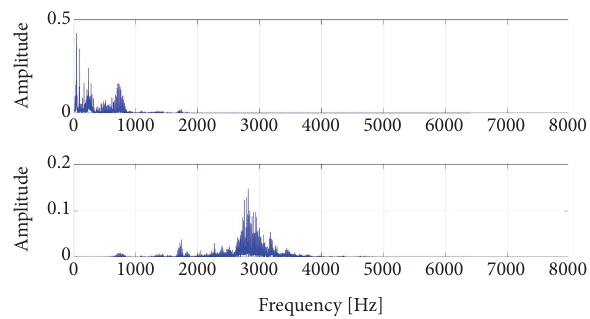
Figure 10: Fourier transforms of two BLIMF components in the terminal stage.